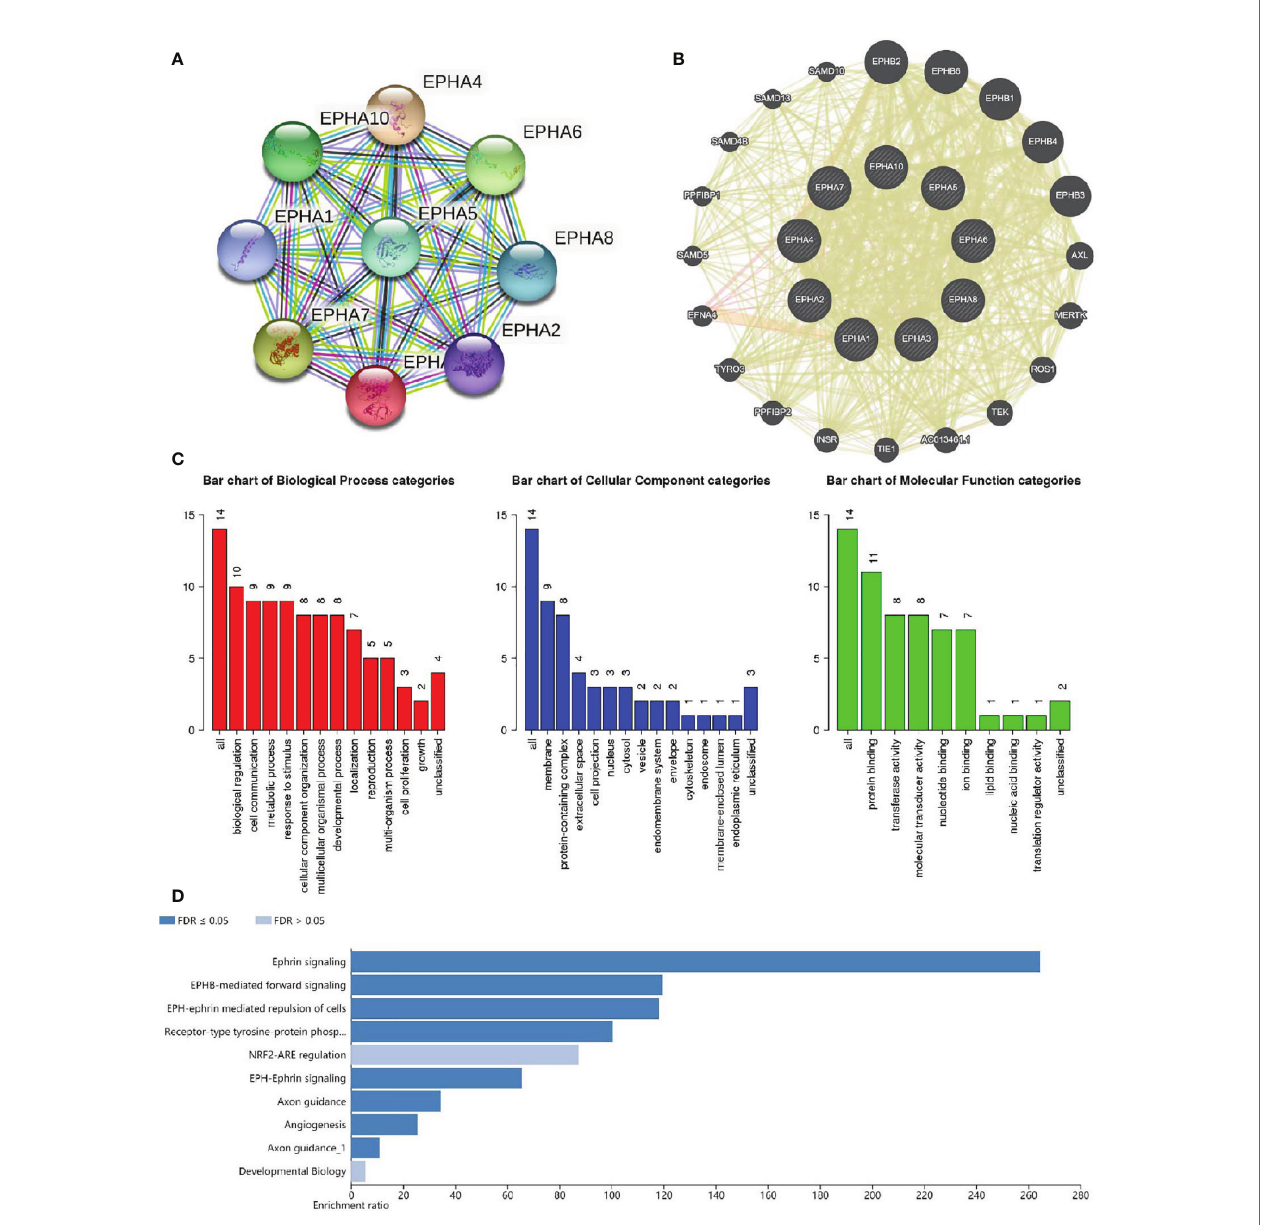
FIGURE 7 | Co-expression and functional analyses for EphA family. (A) Protein-protein interaction network of EphA family. (B) Protein-protein interaction network analyses for EphA2, EphA3, EphA4, and EphA5. (C) Bar plot of GO enrichment in cellular component terms, biological process terms, and molecular function terms for genes in (B) . (D) Bar plot of KEGG enriched terms for genes in (B)